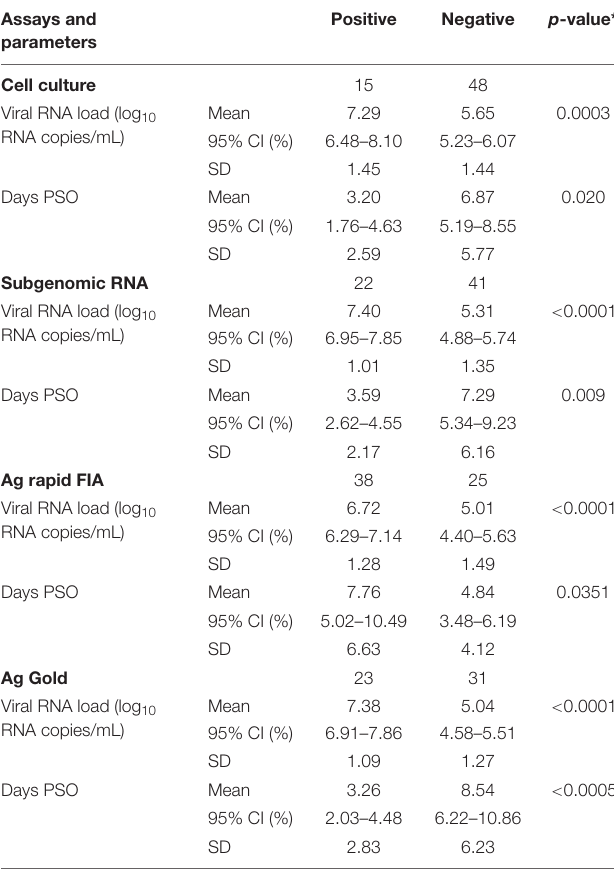
Positive Negative